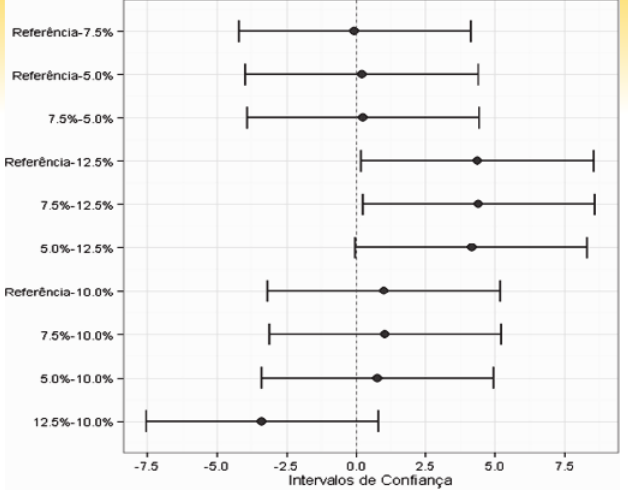
Tukey’s Teat for concretes’ compressive strength at